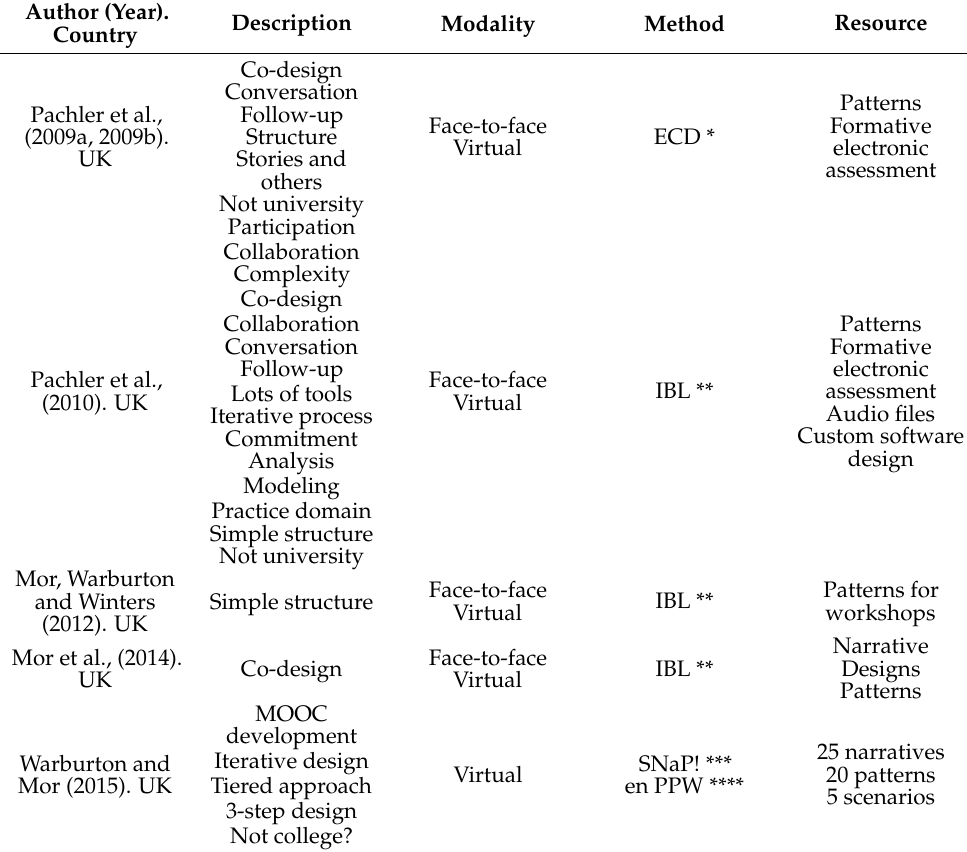
Table 4. Grid of pedagogical patterns in the United Kingdom. Author (Year).